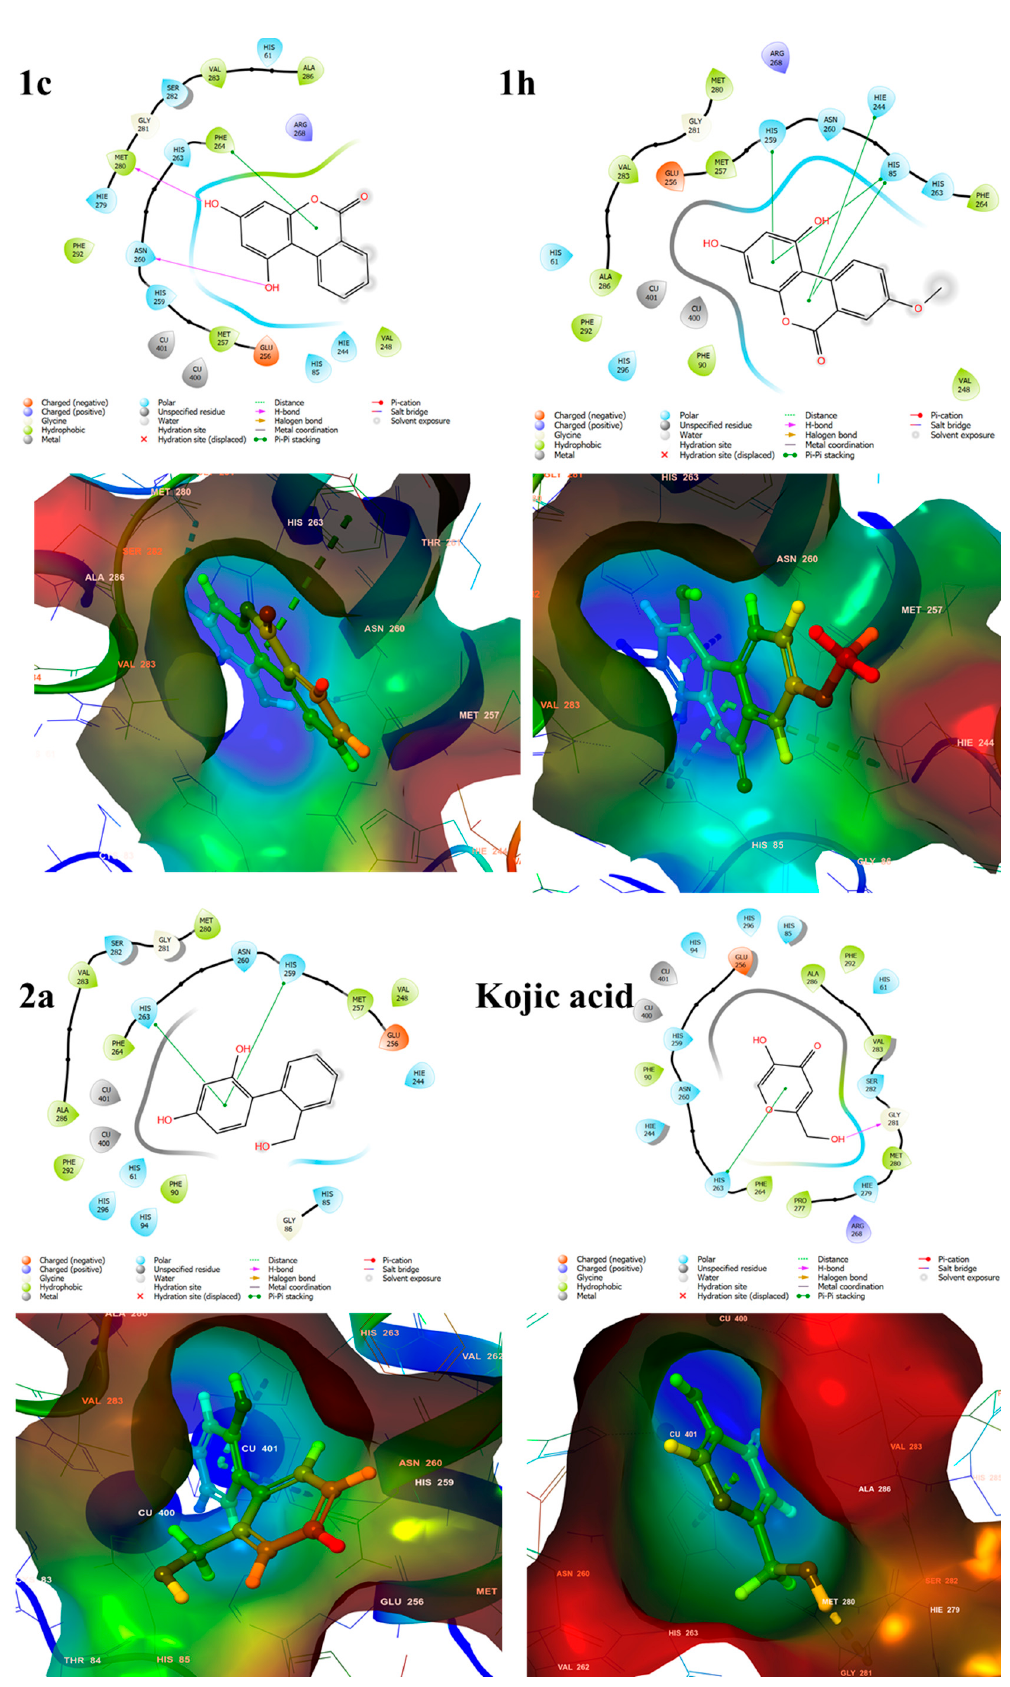
Figure 6. Docking simulation of urolithin derivatives 1c and 1h, o -phenylbenzyl alcohol derivative 2a, and kojic acid with Agaricus bisporus tyrosinase using Schrodinger Suite 2020-2.